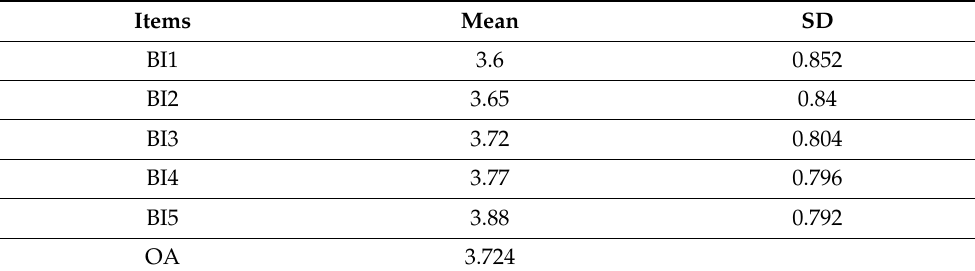
Table 3. Descriptive statistics of each item of behavioral